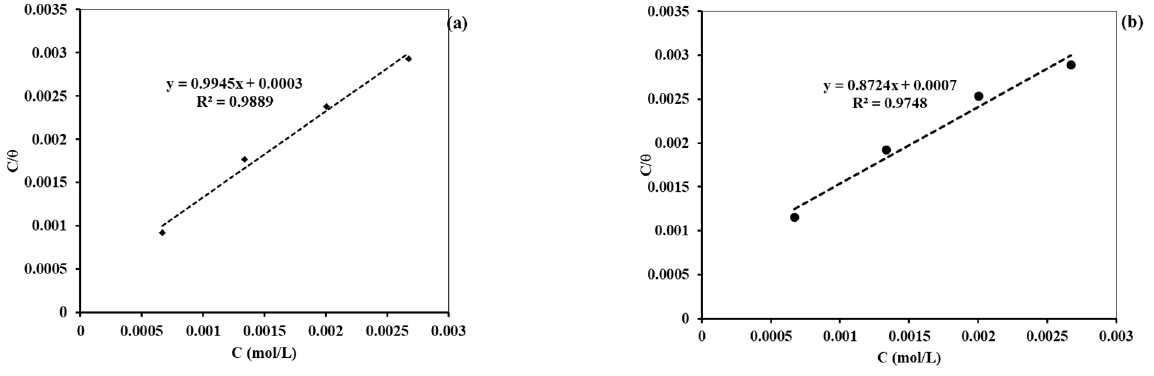
Figure 13. Diagram showing the Langmuir adsorption isotherm from ( a ) PDP data and ( b ) EIS